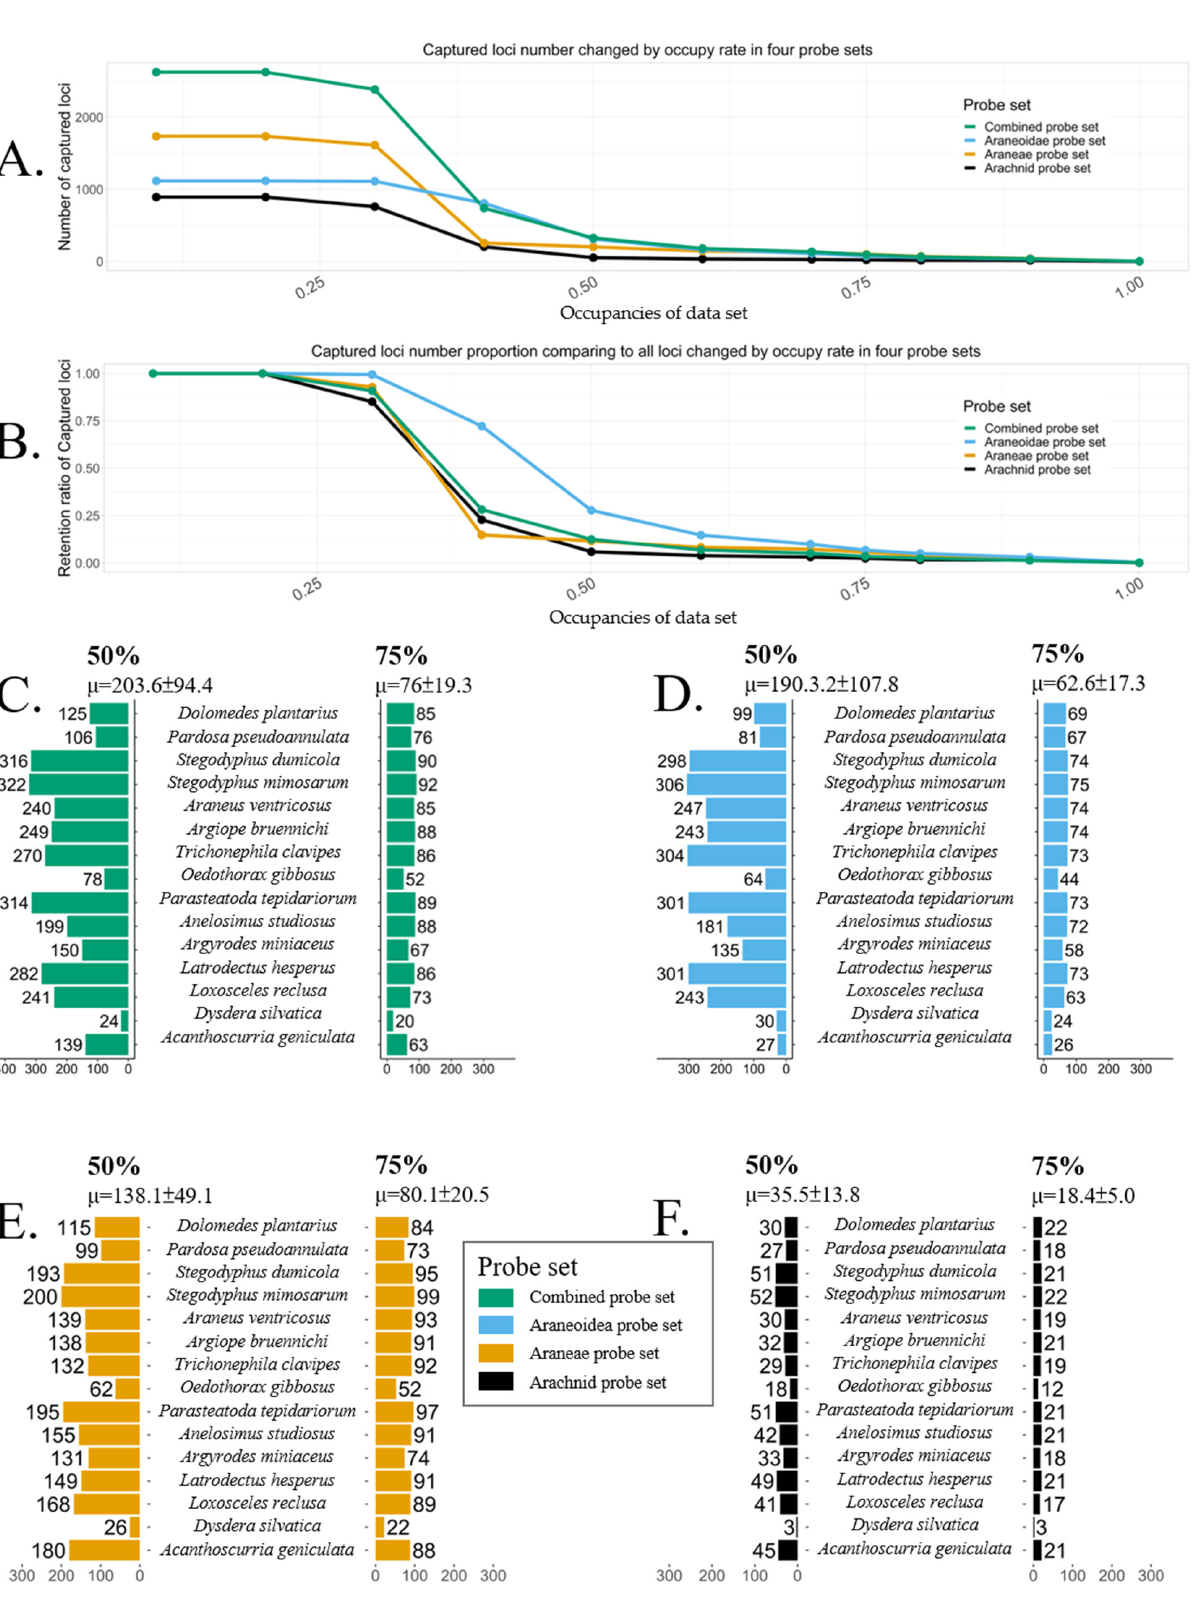
Figure 3. Loci numbers of data sets. ( A , B ) Number of loci changed by filtered increment of 10% (from 10% to 100%) occupancies (for data, see Table S6). ( C – F ) Number of loci used in tree reconstruction of each data set (Table S7).